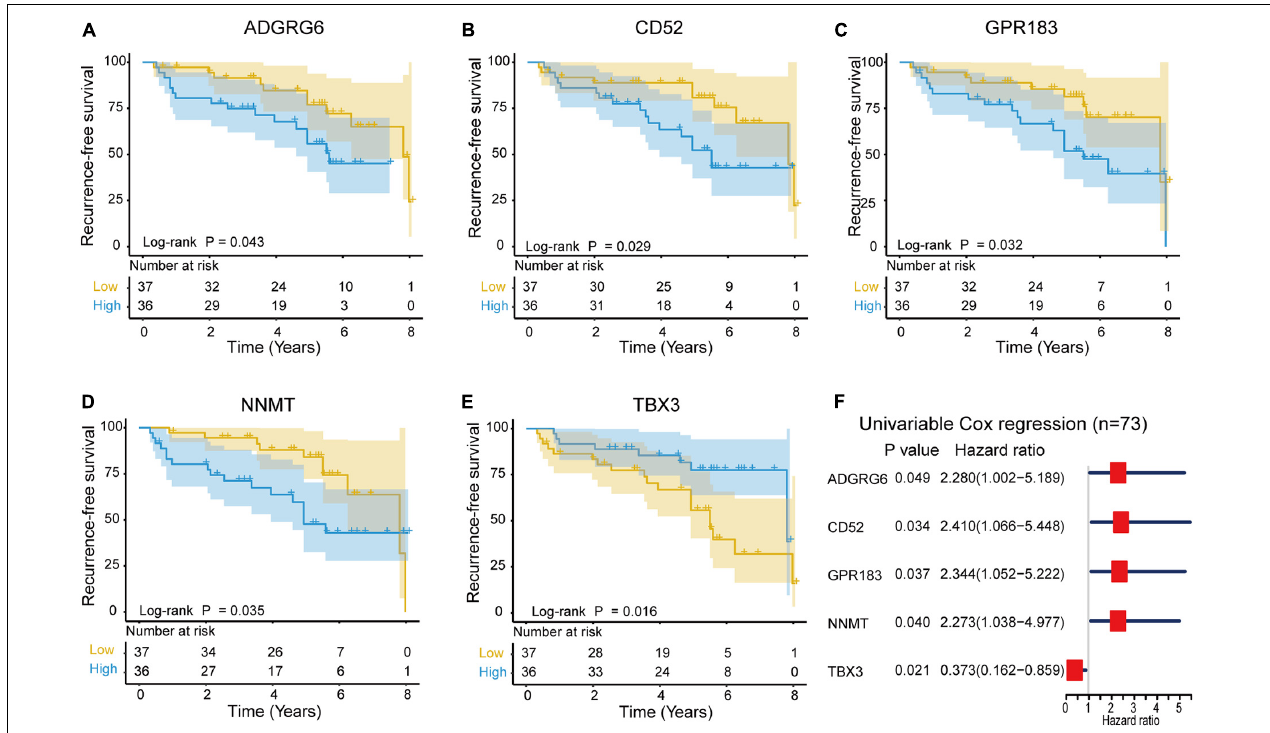
FIGURE 6 | Kaplan–Meier survival curves showing the impact of the expression level of five genes in terms of NFPA recurrence-free survival (RFS). (A–E) Comparison of RFS in the high (red line) and low (blue line) gene expression groups. p < 0.05 was used to assess differences in the Log rank test. (F) Forest plot of hazard ratios for these five prognostic DEGs. Hazard ratios and corresponding 95% confidence intervals were assessed through univariable Cox